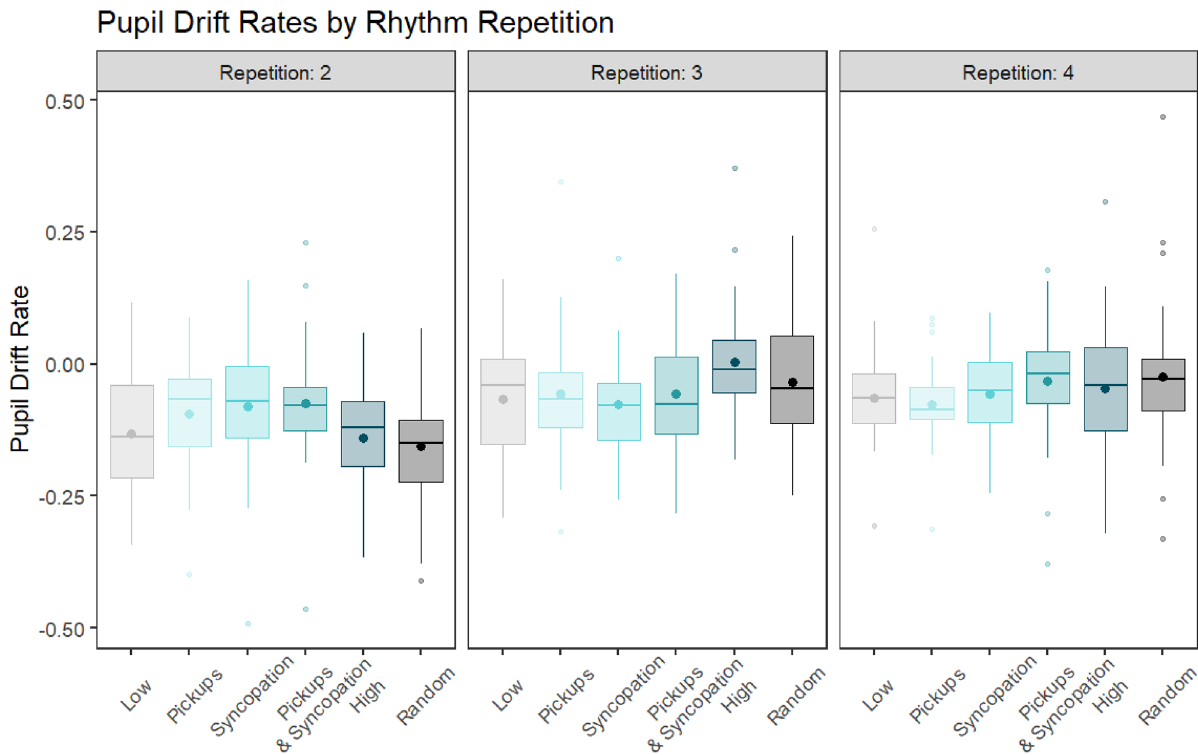
Figure 5. Pupil drift rates by condition across the remaining three within-trial drumbeat repetitions. Drift rates were calculated by averaging the pupil sizes in the first and last three time bins of each repetition with each trial and then computing the slope between these two averages. Large dots represent